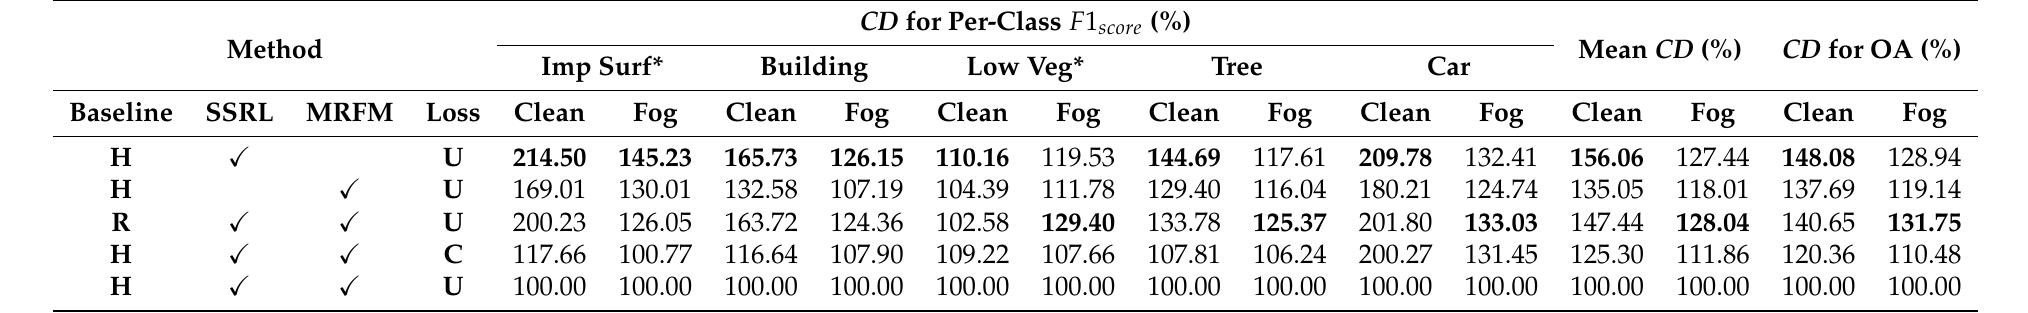
Table 3. CD in ablation study with different components integrated based on clean and fog corrupted variants of the Vaihingen test set. Our framework is regarded as the reference and values above 100% denote a decrease in robustness compared with the reference. The highest CD is